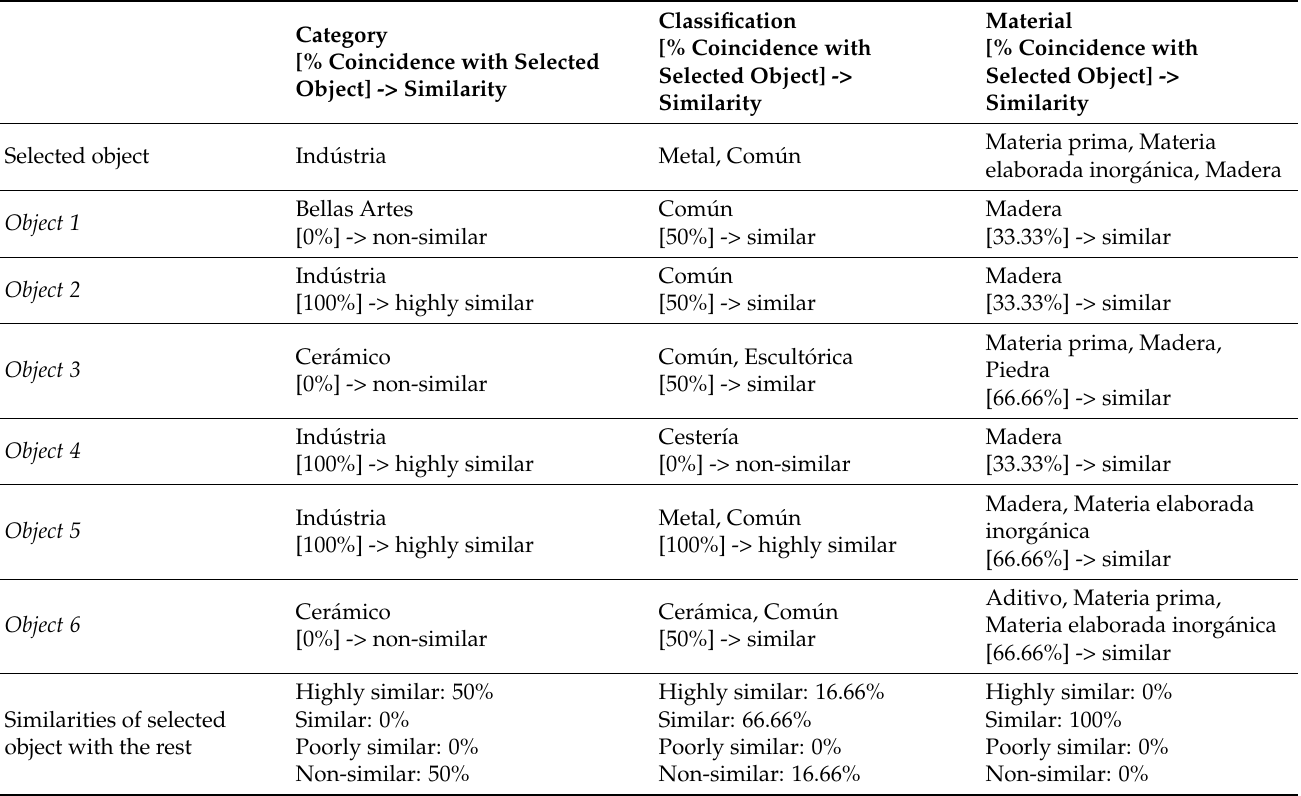
Table 2. Example of how the similarities between a selected object and the rest of the objects are computed for each of the considered properties (category, classification, and